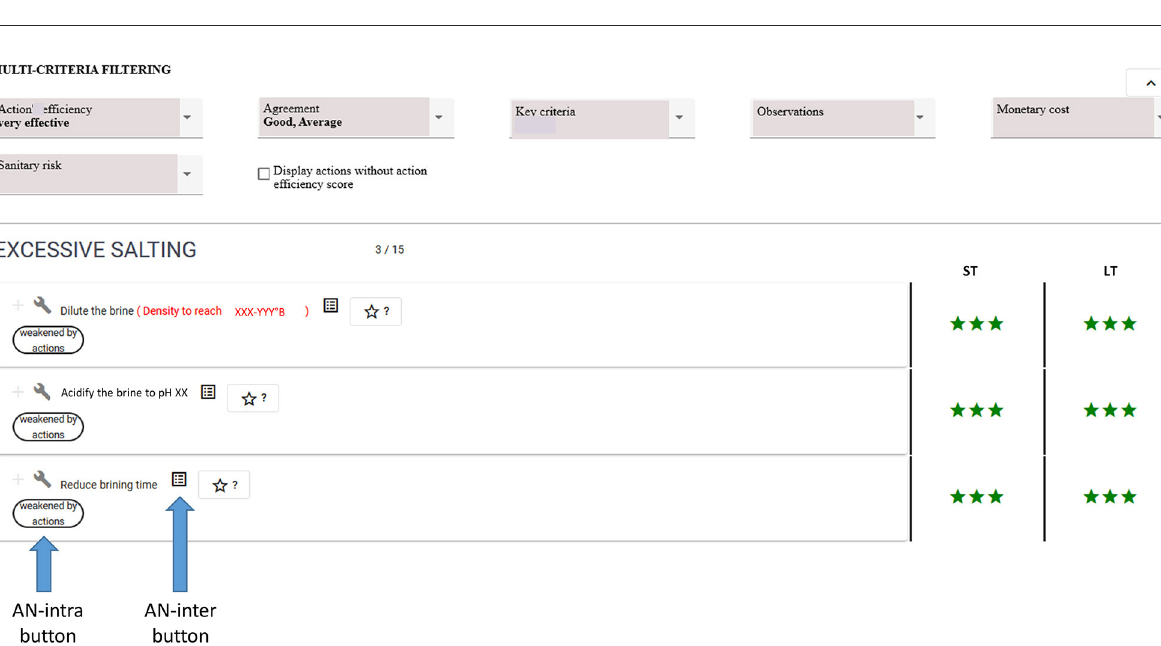
designed to assess the impact of MCDSS use in this reasoning